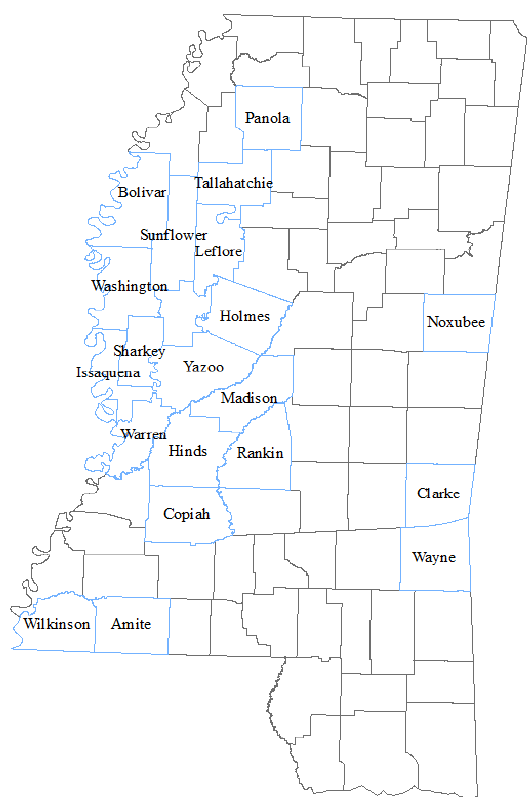
Figure 5. Top 20 counties in Mississippi with a potential capacity of more than 8 MW based on combined use of corn stover and forest logging residue.